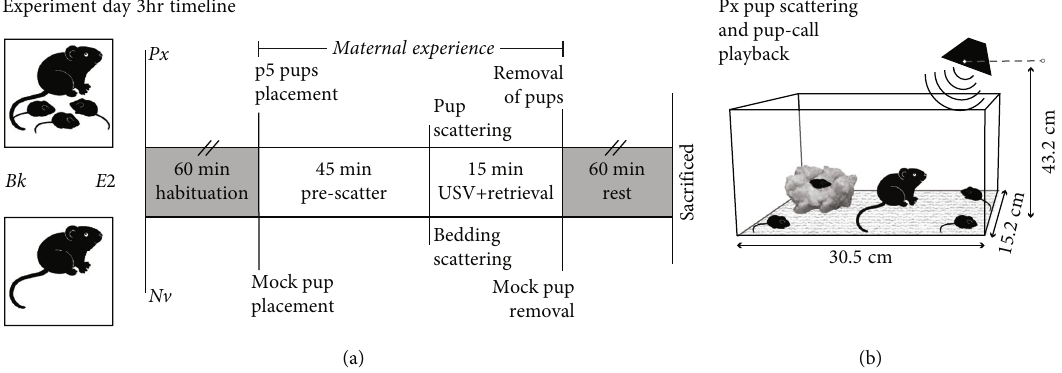
Figure 1: Experimental timeline. (a) Virgin female mice were ovariectomized and implanted with a blank (Bk) or estradiol (E2) implant. On the experiment day, half of the subjects received 1 hour (hr) of social experience with pups (Px), while the other half remained naïve (Nv) to pups. Experiments were run inside an anechoic chamber, beginning with 1hr of solo habituation. Then, Px subjects experienced (top of timeline) 4 pups placed in their cage while Nv subjects experienced (bottom of timeline) mock pup placement. (b) After 45 min, pup-call stimuli were played for both conditions. For Px subjects, playback occurred during a pup scattering session; Nv subjects were subjected to a nest disturbance session to mimic pup scattering. Pups were removed (Px subjects) after 1hr, and all subjects were sacri fi ced 2hr after pup or mock pup placement, to assess gene